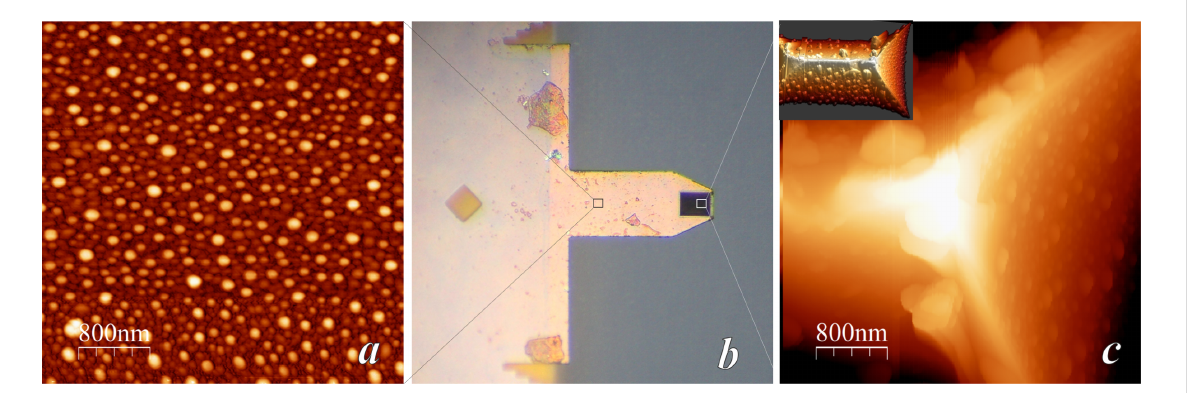
Figure 1: AFM images (a, c) and optical image (b) of the tip side of an Olympus OMCL-HA-100 AFM cantilever. Image sizes: 4 × 4 μ m 2 and 80 nm height scale for the AFM image in panel (a) showing the flat region of the cantilever; about 300 × 300 μ m 2 for the optical image in panel (b); and 4 × 4 μ m 2 and 2 µm height scale for the AFM image in panel (c) showing the tip region of the cantilever. The inset in the right AFM image shows a 3D representation of (almost) the whole cantilever tip. The dotted squares in the optical image mark the two regions where the AFM images have been